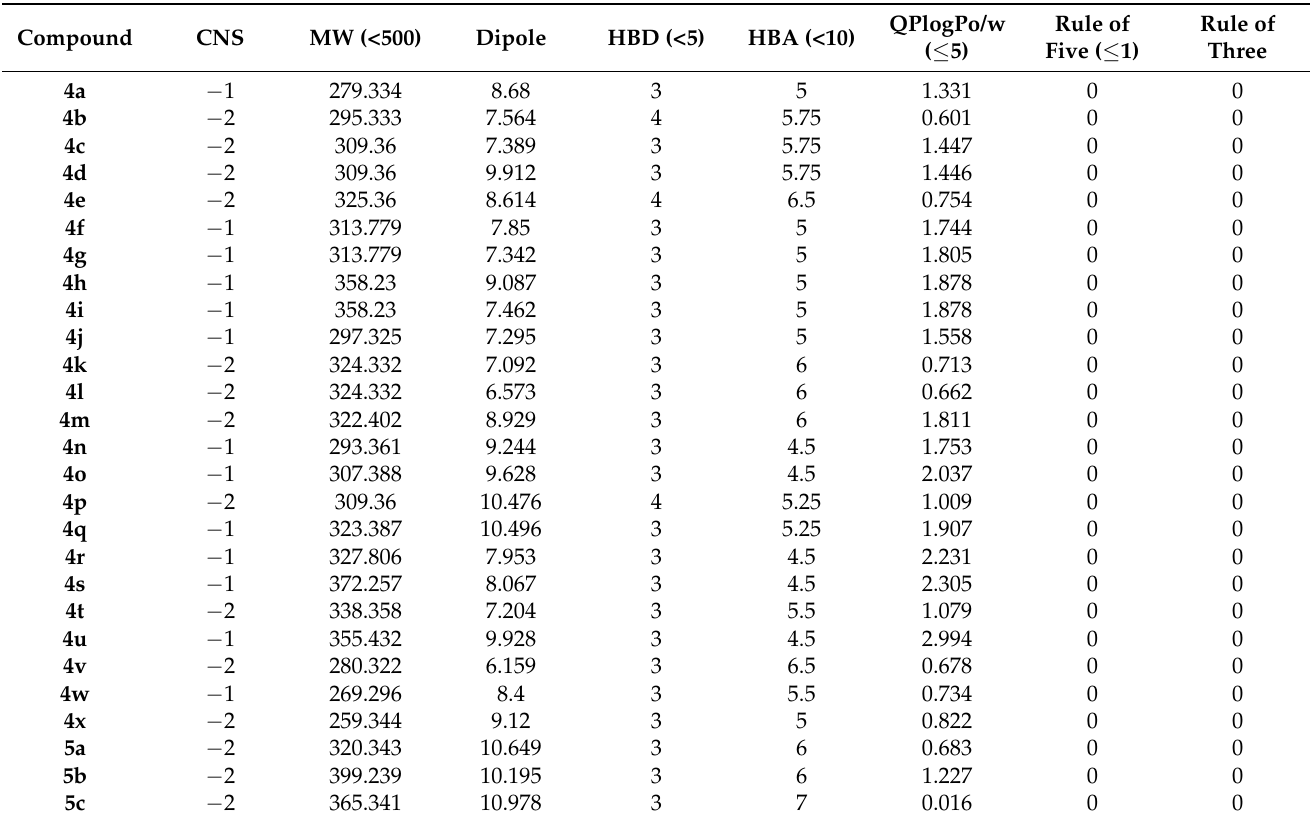
Table 5. Result of ADME properties of compounds taken for QSAR